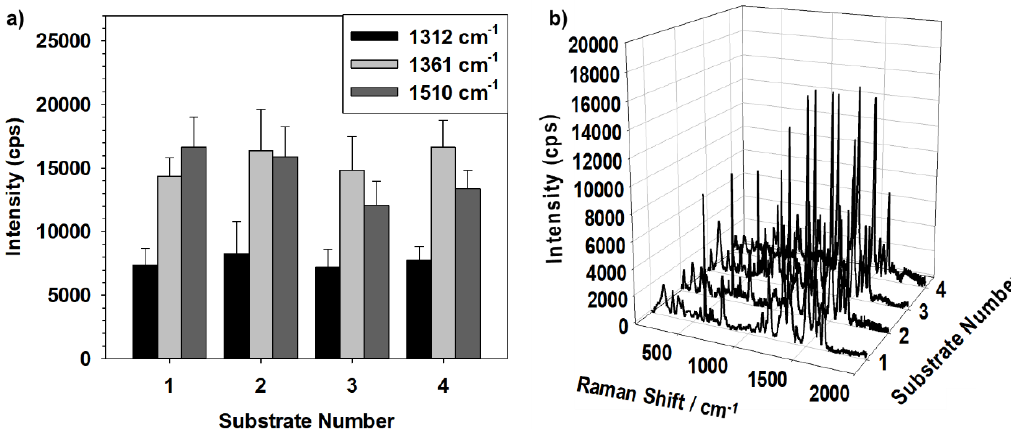
Figure 5. Reproducibility of prepared SMPs3. ( a ) Peak intensities of 10 − 5 M of R6G treated SMPs3 from each synthetic procedure. ( b ) Representative Raman spectra from Figure 5a. ( λ = 633 nm, laser power: 5 mW).